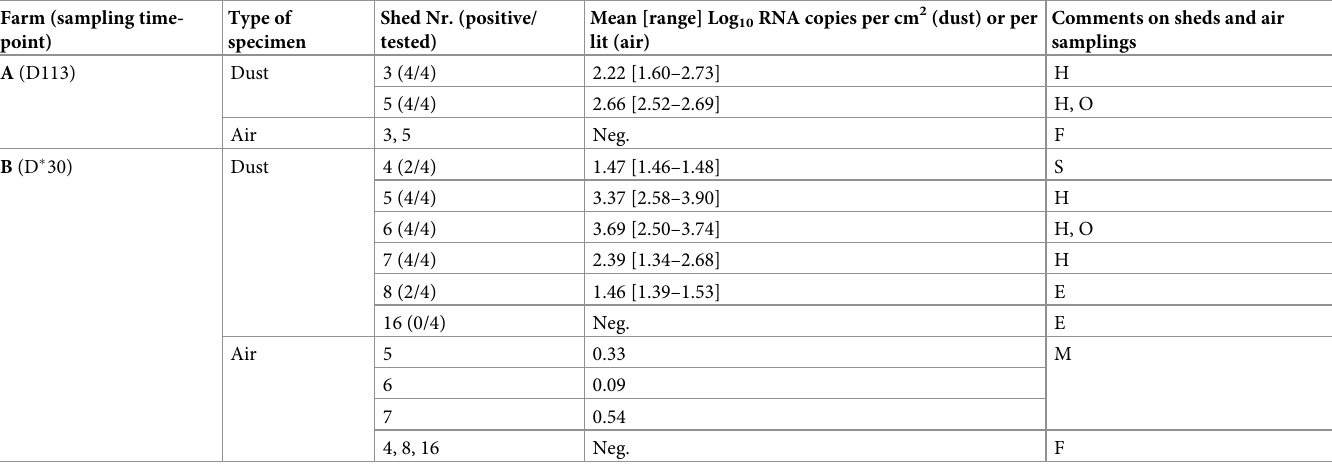
F (fixed-spot): the microbial air sampler was placed on a fixed spot for sampling; M (moved): the air sampling was being performed in parallel to blood sampling and the microbial air sampler was being moved in the respective sheds; E (empty): sheds that were empty during the whole investigation period; H (housed): sheds wherein animals were being housed during the whole investigation period; O (onset): sheds wherein the onset of cases was recorded in each farm; S: empty (at the time of dust and air sampling) shed, wherein minks with signs were being isolated during the course of the